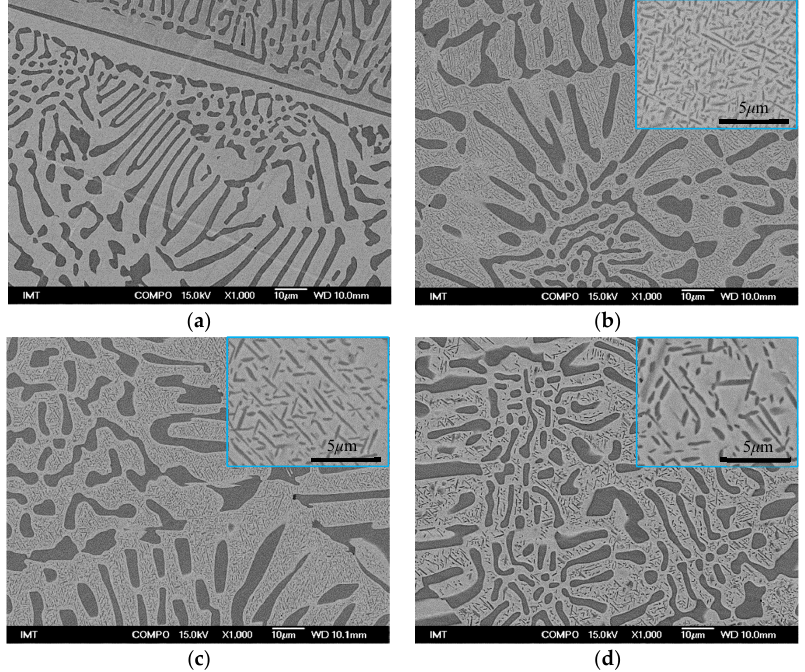
Figure 3. SEM-BSE images of the microstructure of: ( a ) As-cast AlCoCrFeNi 2.1 CCA with B2 (BCC) lamellae—dark grey and L1 2 (FCC) phase—light grey; Precipitation and coarsening of fine B2-like phase inside L1 2 after aging at 800 °C for: ( b ) 100 h; ( c ) 500 h; ( d ) 1000 h.